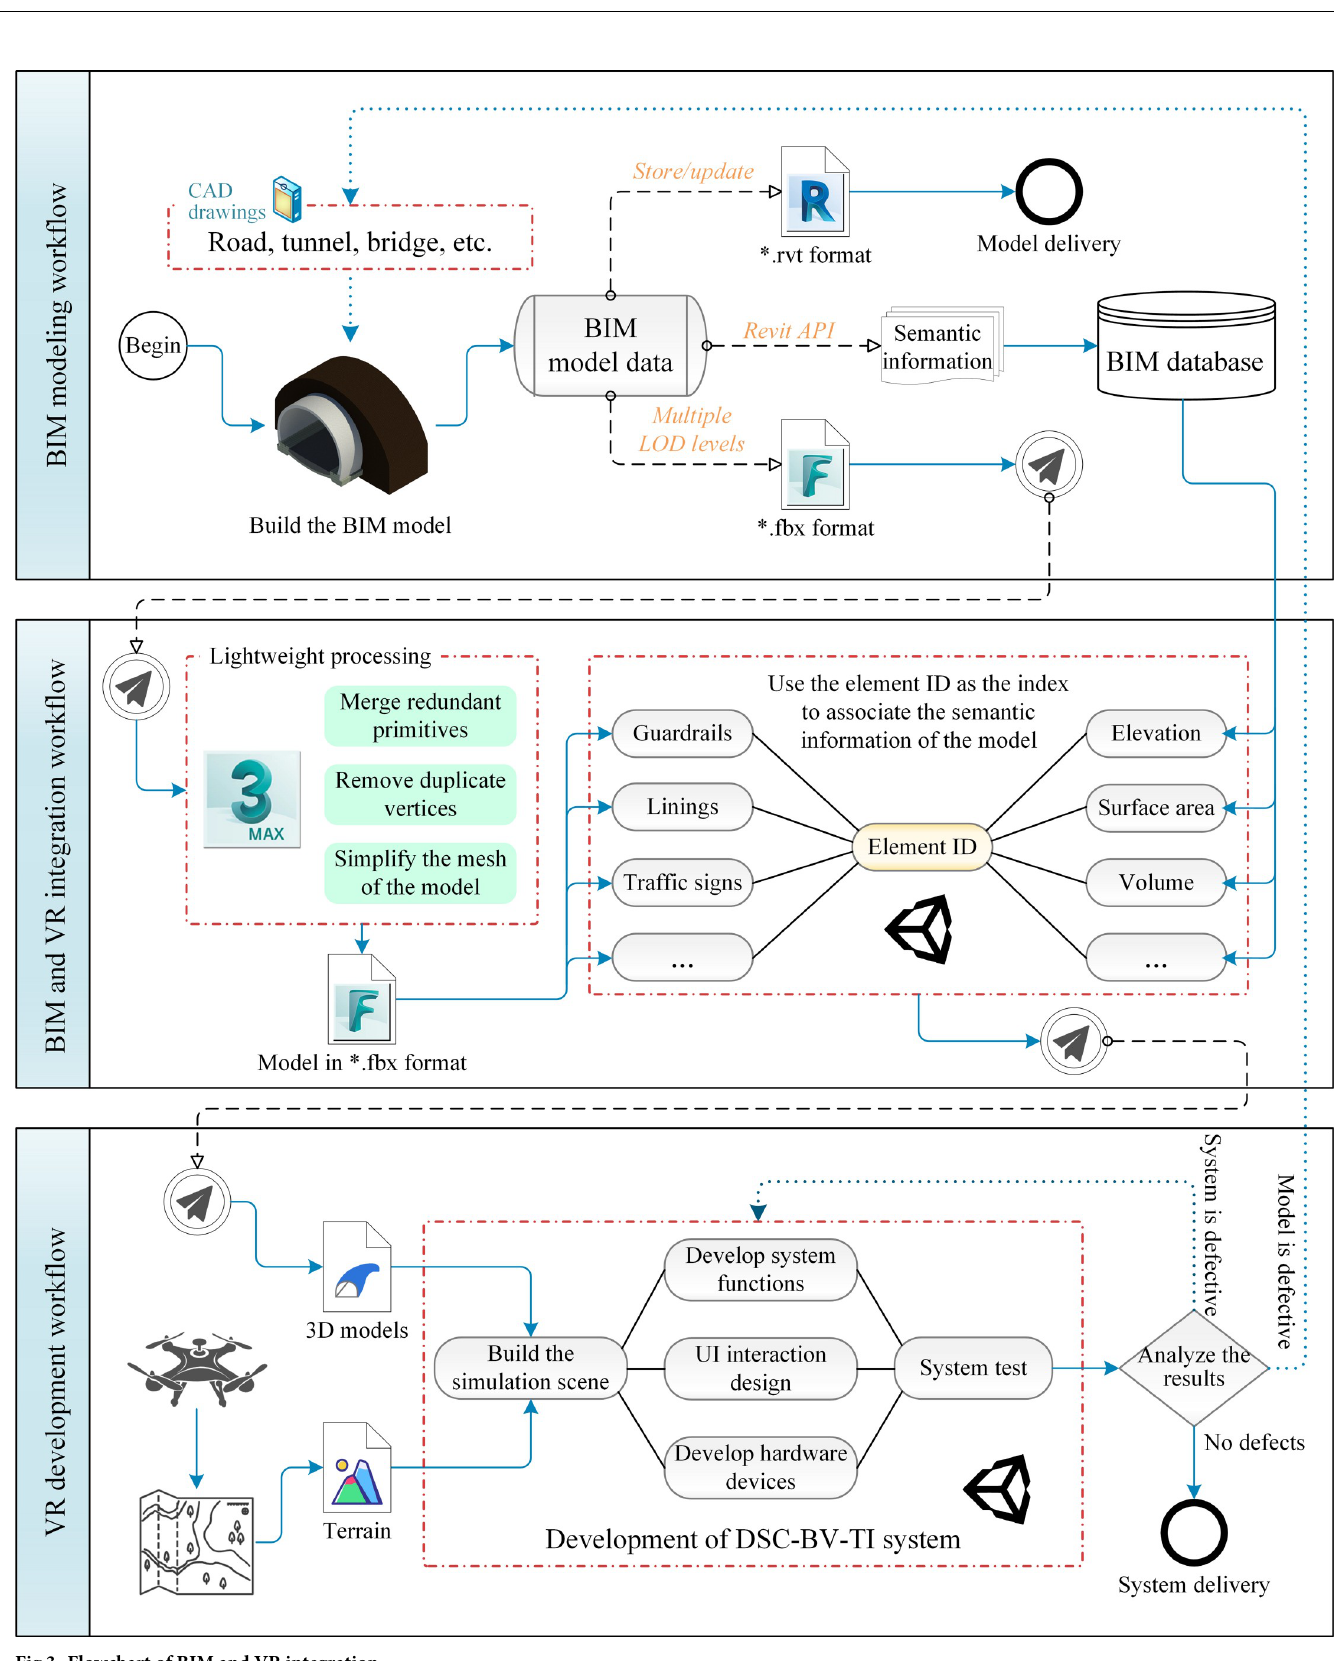
Fig 3. Flowchart of BIM and VR integration. https://doi.org/10.1371/journal.pone.0259046.g003 PLOS ONE | https://doi.org/10.1371/journal.pone.0259046 November11,